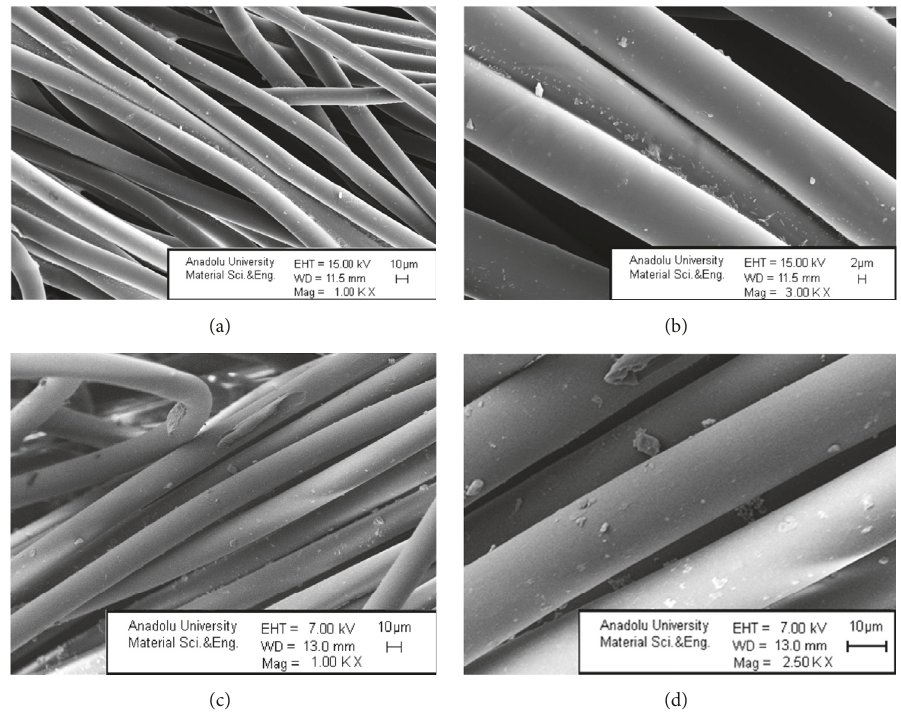
Figure 6: SEM test results of fabric samples. (a) PSY (1,000X); (b) PSY (3,000X); (c) PSY-Z20 (1,000X); (d) PSY-Z20